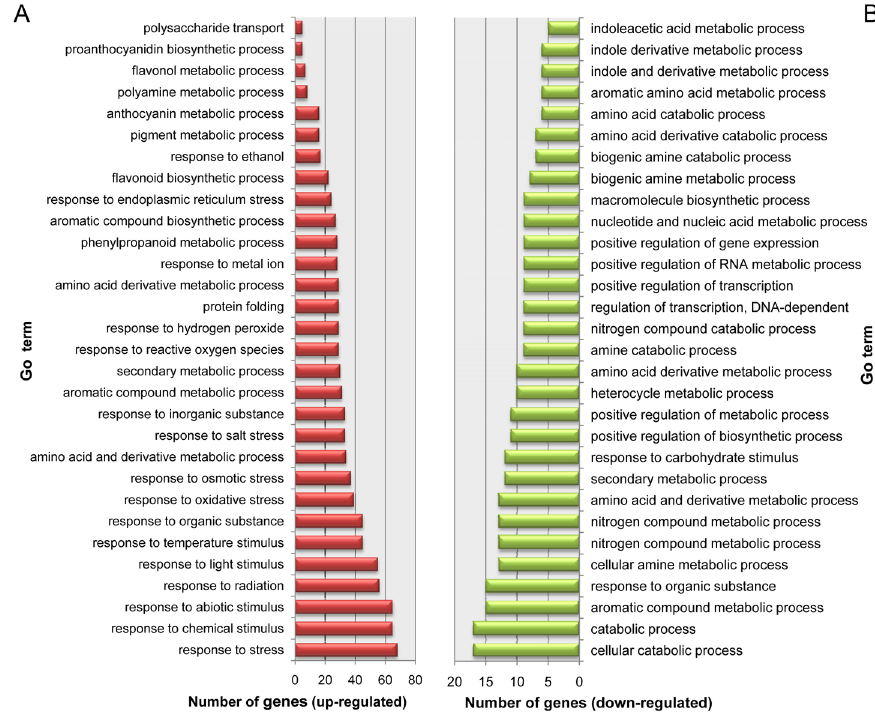
Fig 4. GO terms enriched in differentially expressed genes between red- and white-fleshed apples. (A) GO terms enriched in up-regulated genes in red-fleshed apple. (B) GO terms enriched in down-regulated genes in red-fleshed